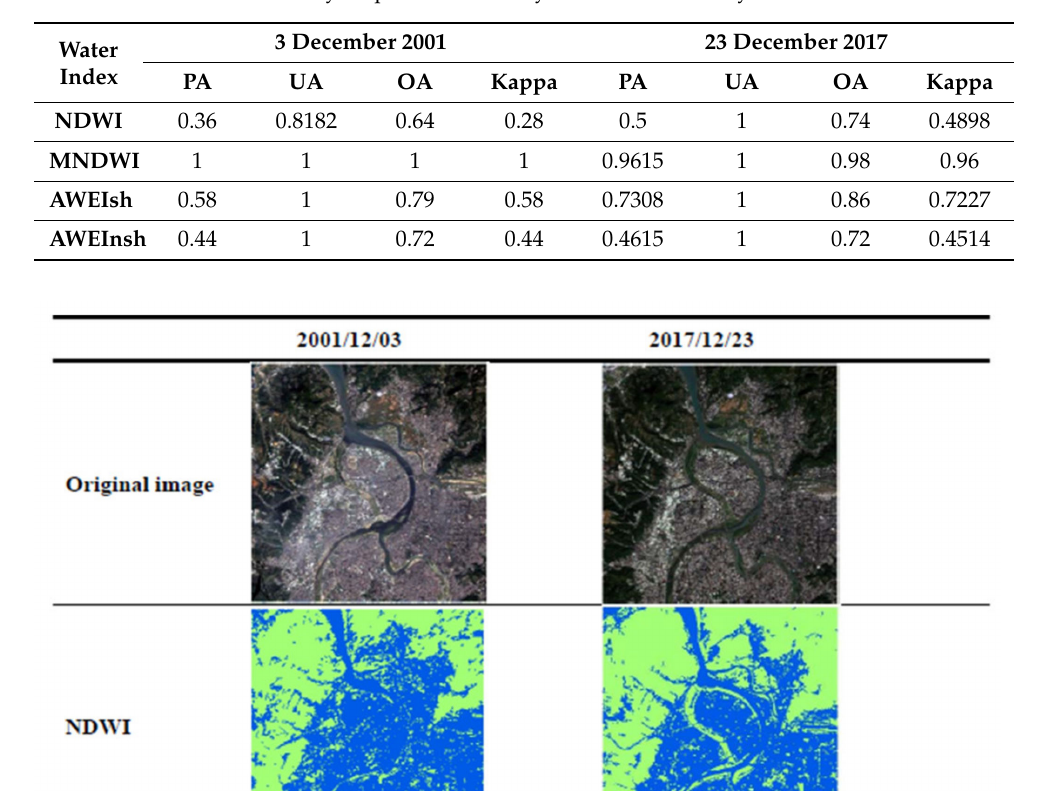
Table 6. Tamsui River: Accuracy of spectral water body indices in water body extraction on different dates.